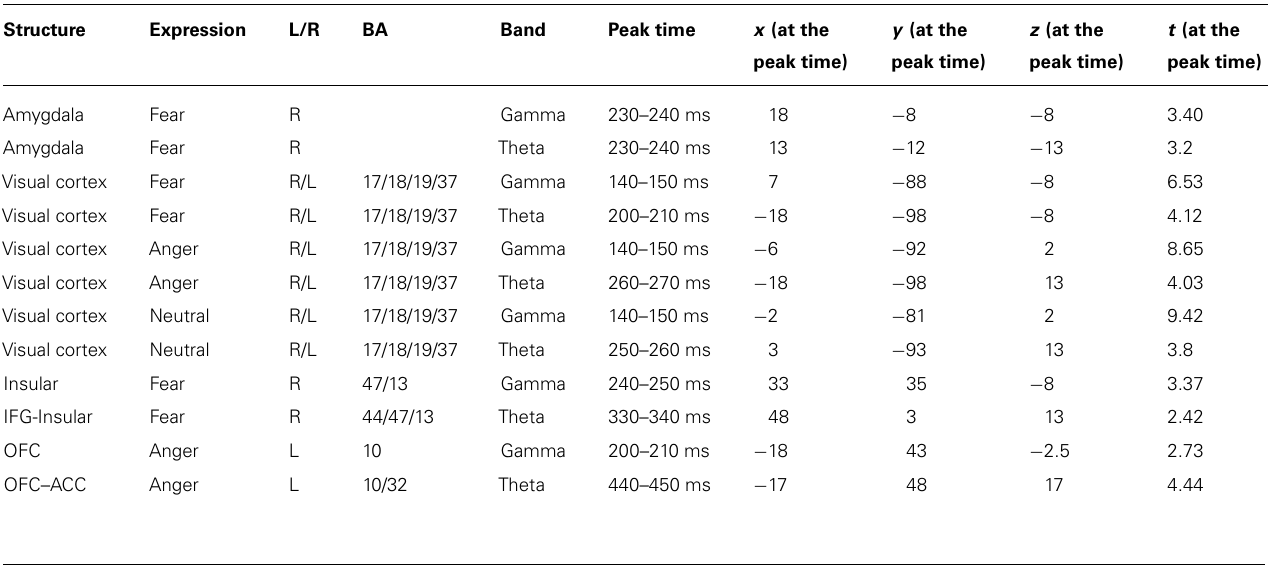
Table 1 | Spatiotemporal information of significant ERS in the gamma and theta